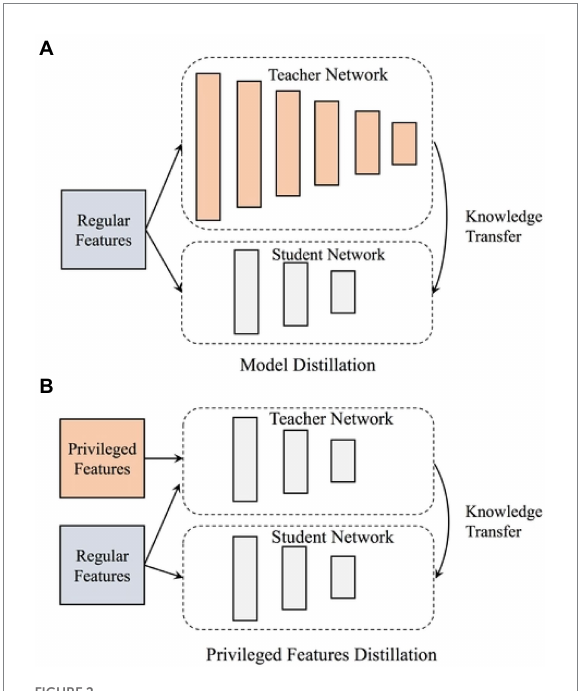
FIGURE 2 Deep learning operation model diagram. (A) Model distillation and (B) privileged features distillation.